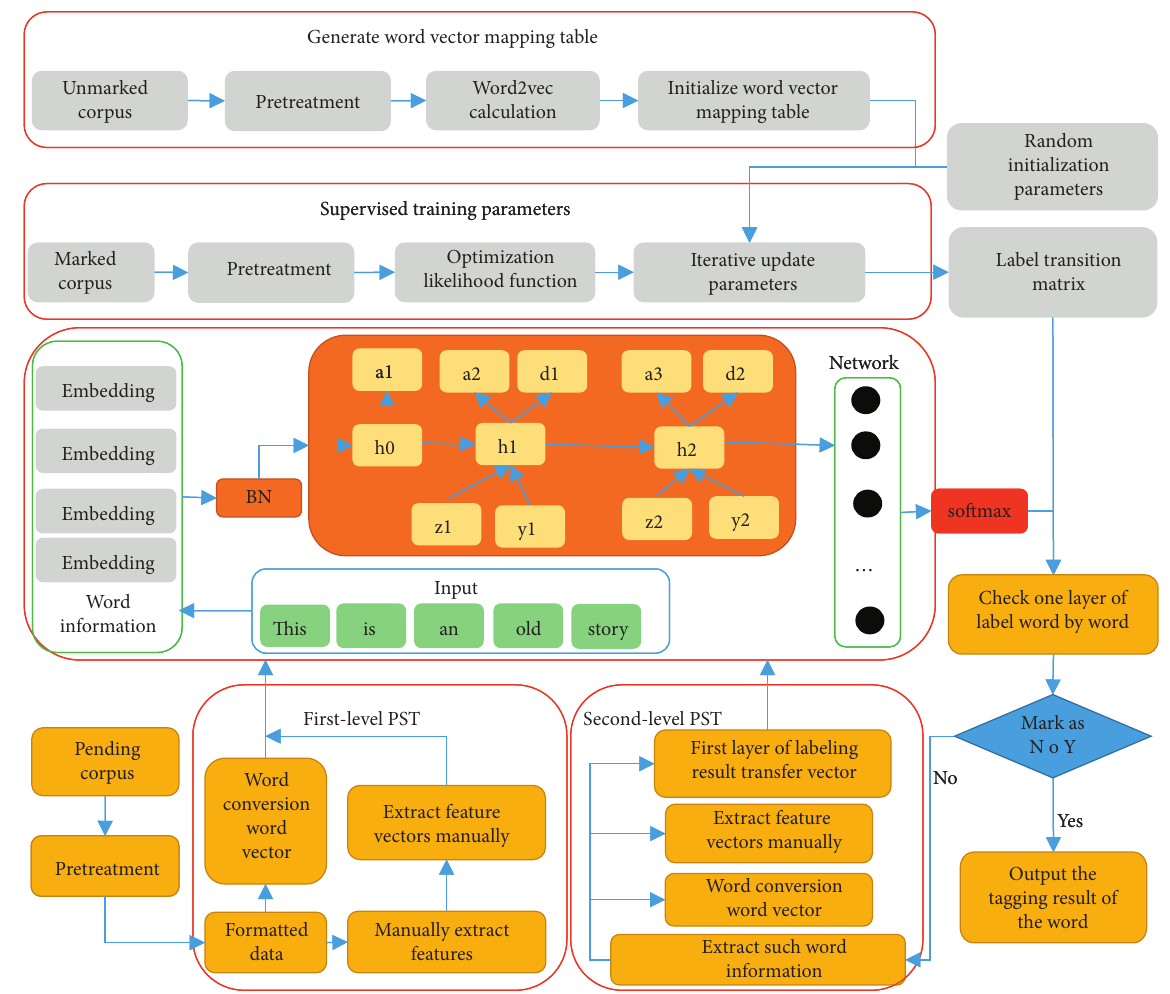
Figure 1: Part-of-speech tagging model based on recurrent neural